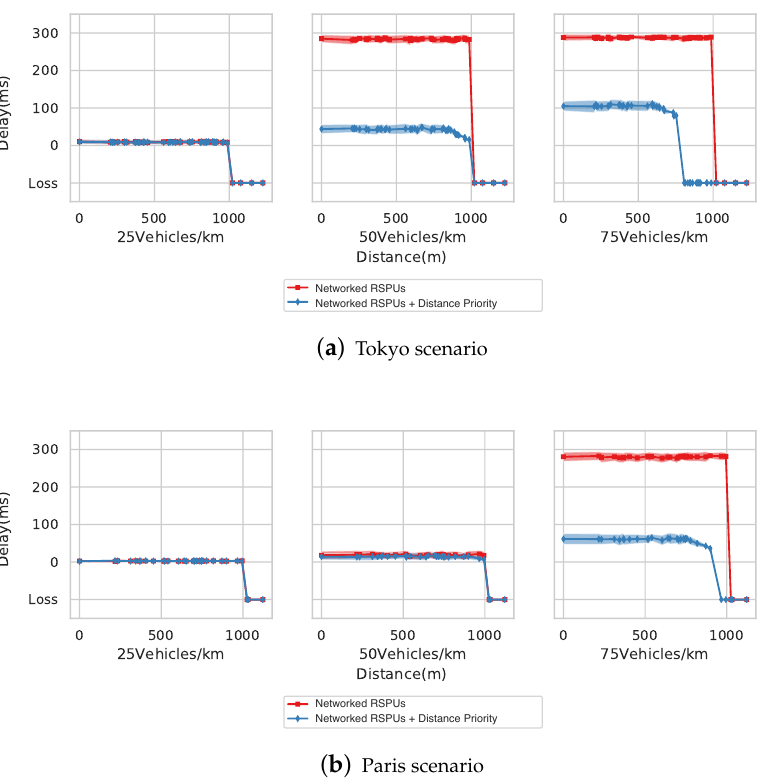
Figure 12. Evaluation of delays. ( a ) Tokyo scenarios, ( b ) Paris